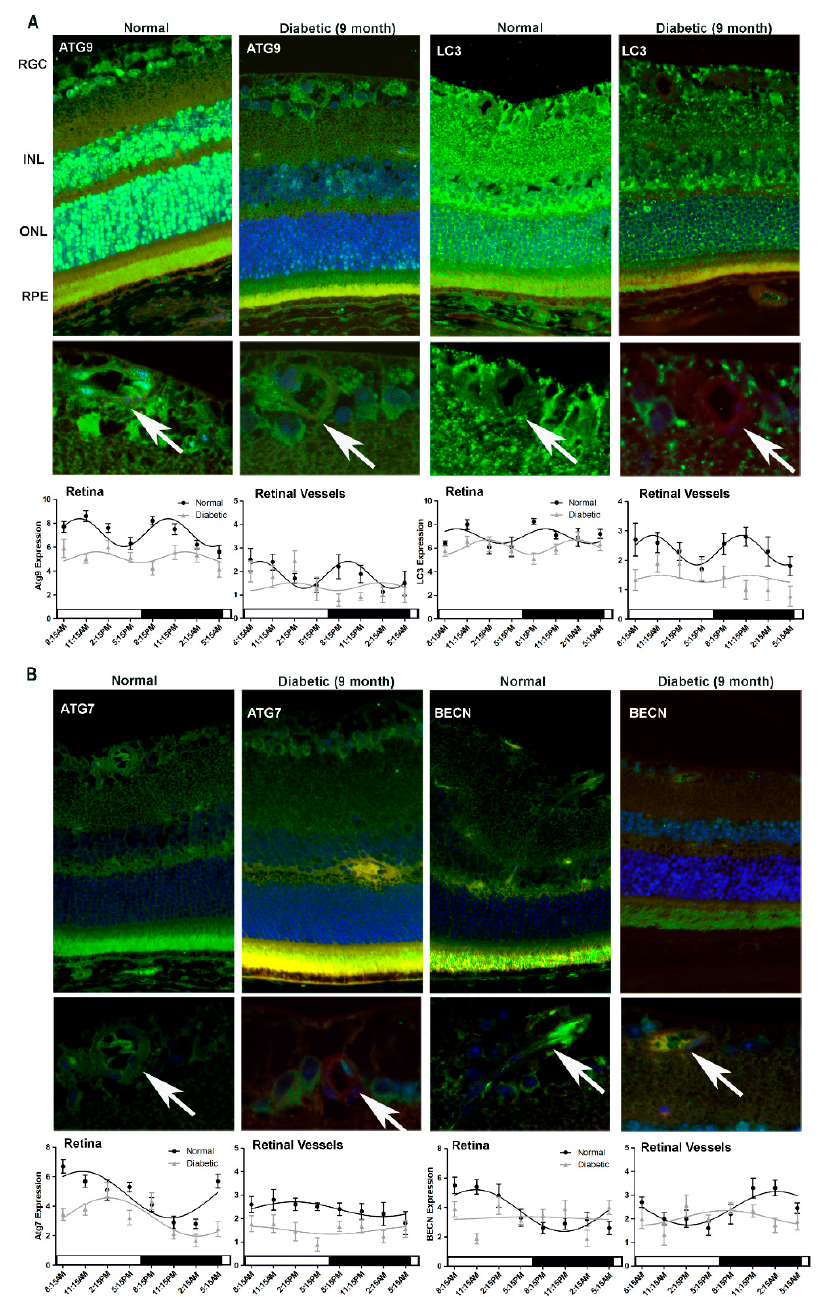
Figure 6. Impairment of diurnal rhythmicity of autophagy in T1D mice with nine-months duration of diabetes. Retinas were collected from C57Bl / 6J mice with nine-months duration of T1D and age-matched control mice. Immunostaining and intensity analyses of retina and retinal vasculature demonstrated a dramatic loss of oscillatory amplitude of autophagic protein expression in the diabetic animals compared to normal mice ( A . B ). Autophagy protein expression is green, TRITC agglutinin for vessels red and DAPI nuclear staining blue. The arrows indicate autophagy protein localization to retinal vessels. RGC, retina ganglion cell; INL, inner nuclear layer; OPL, outer plexiform layer; ONL, outer nuclear layer; RPE, retinal pigment epithelium. Loss and phase-shifting of diurnal rhythmicity in diabetic retinopathy is demonstrated in single cosine plot with ordinary least square fitted ( p < 0.01, n = 10). All animals were maintained in a standard 12 / 12-h light / dark phase with lights ON at 6:00 AM and lights OFF at 6:00 PM. The error bars in the circadian plots represent the mean + SEM and diurnal oscillation had a p -value less than 0.05.